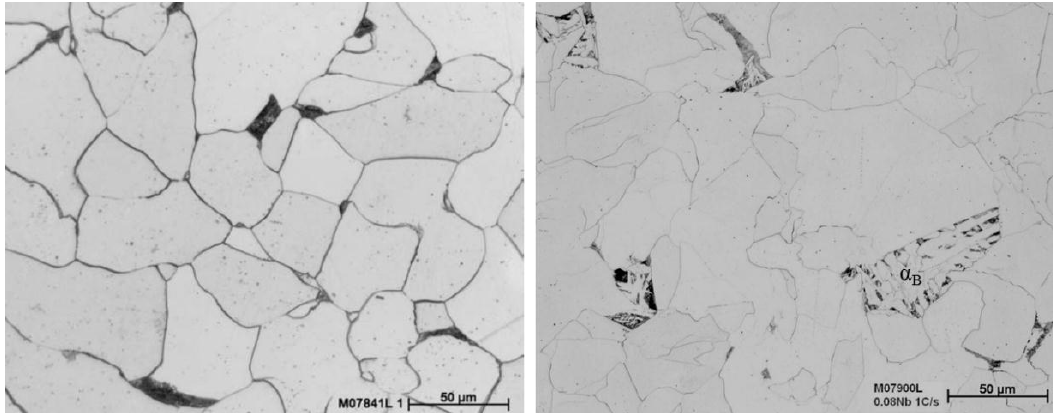
Figure 4. Optical micrographs for a cooling rate of 1 °C/s, showing the effect of Nb, where ( a ) base grade (0% Nb), consisting of regular ferrite and pearlite and ( b ) 0.08% Nb Steel, showing a greater degree of irregularity of the ferrite plus regions of granular bainite, α B .